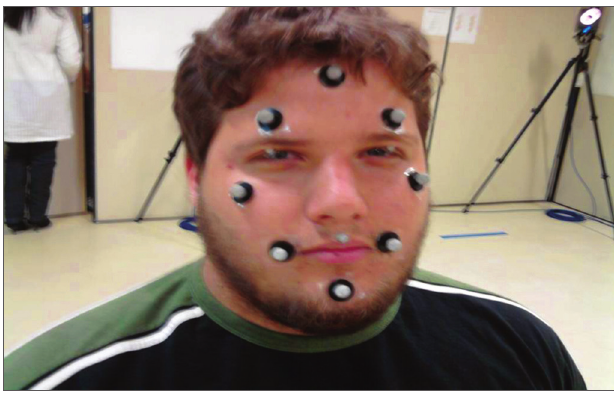
Figura 3. Examinando com os marcadores estabelecidos em pontos estratégicos na